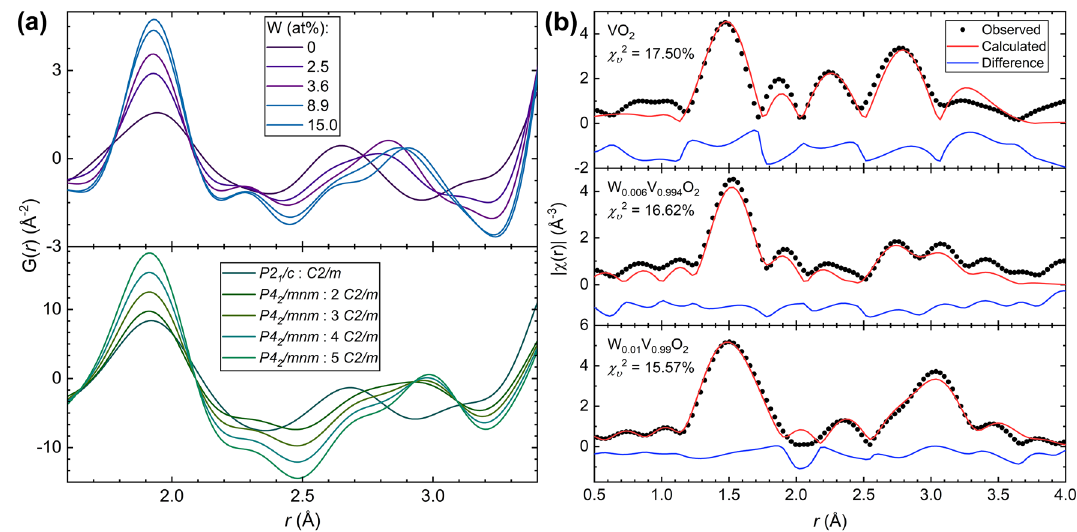
Figure 7. V oxidation is correlated with W-substitution as supported by ( a ) PDF simulations of varying amounts of V 6 O 13 ( C 2/ m ) to either VO 2 ( P 2 1 / c ) or VO 2 ( P 4 2 / mnm ) capture the local features of the PDF upon increasing W substitution amount and (Alliance of Bioversity International and CIAT—Multifunctional Landscapes) V K -edge EXAFS fitting to paths from the following structures: VO 2 ( P 2 1 / c ), V 6 O 13 ( C 2/ m ), V 2 O 5 ( Pnma ), and in the case of the W-substituted samples VO 2 ( P 2 1 / c ), V 6 O 13 ( C 2/ m ), V 2 O 5 ( Pnma ), and VO 2 ( P 4 2 / mnm